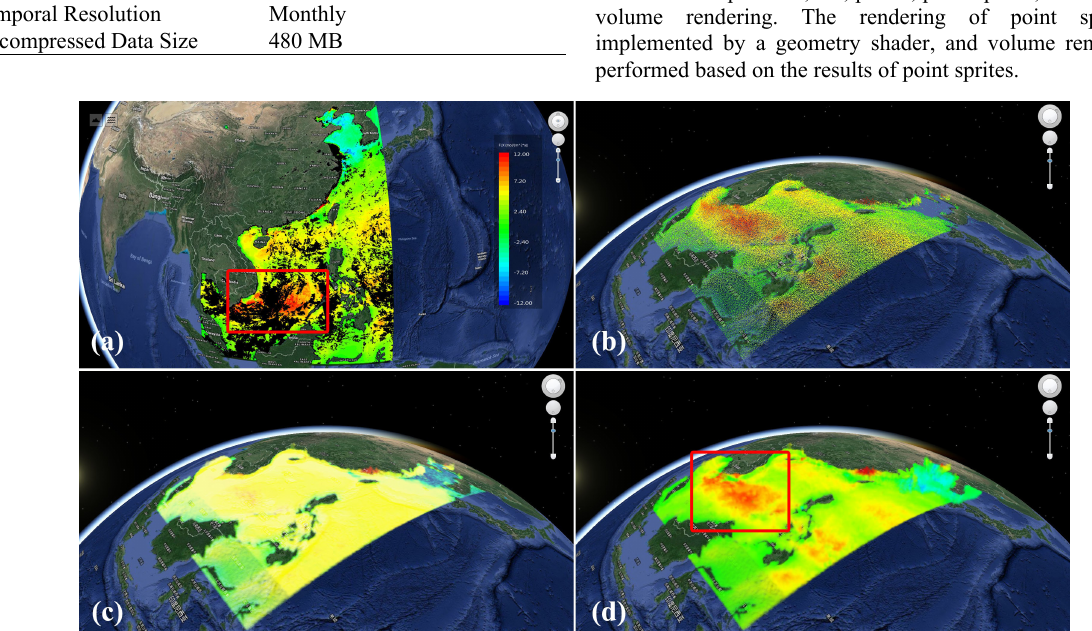
Figure 12. The original satellite data (a) and CO 2 flux particles rendering with points (b), point sprites (c) and volume rendering (d) on the